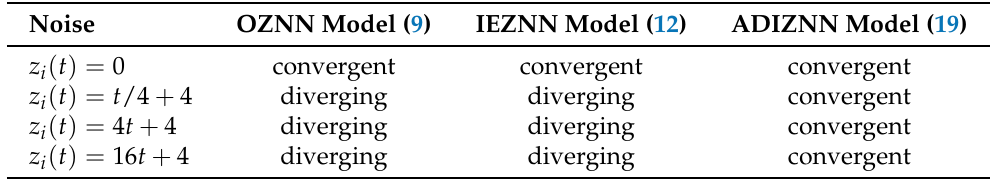
Table 1. The detailed comparison of OZNN (9), IEZNN (12) and ADIZNN (19) with ξ = 2 and λ = 1 for the DSE with (35) under the different noise environments.